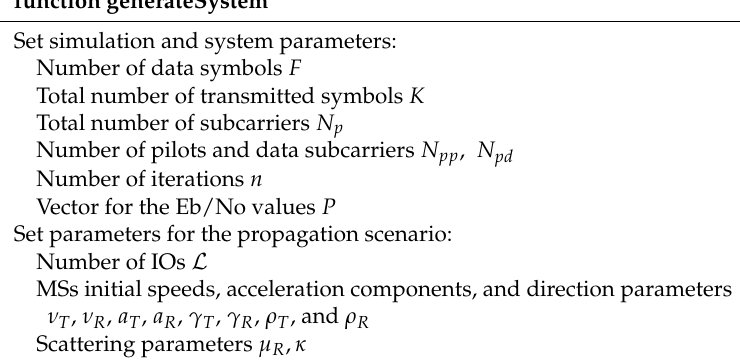
Table 4. Pseudocode for the simulation of V2X communications